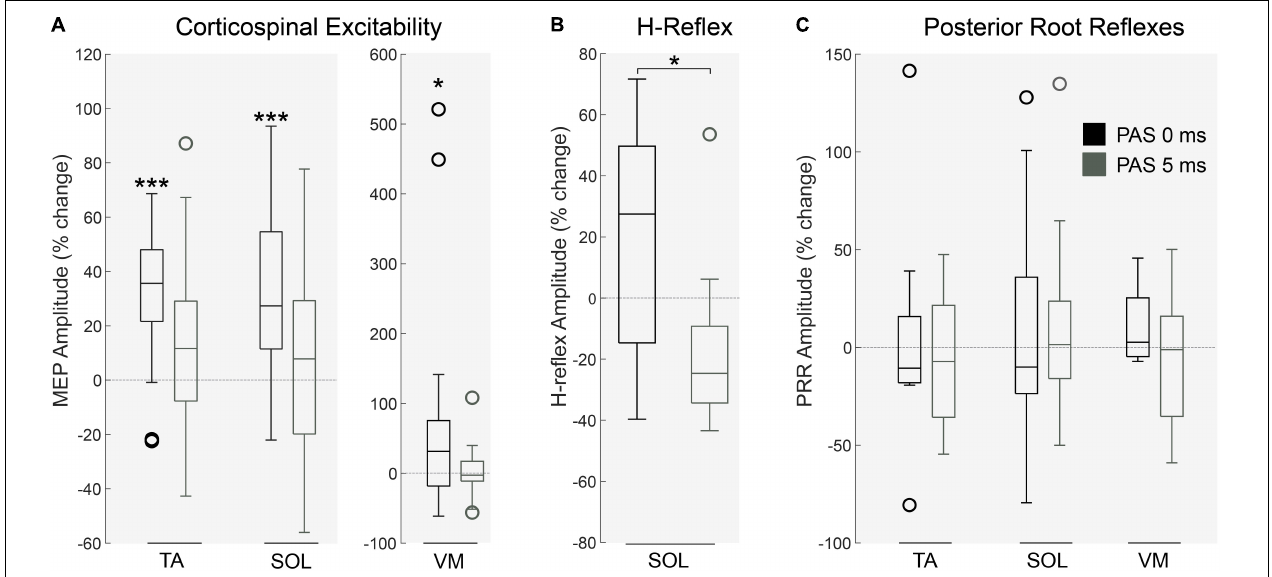
FIGURE 3 | Physiological changes following PAS protocol. (A) Corticospinal excitability in the right lower leg muscles was significantly altered by PAS interval ( p < 0.01, n = 22) in the TA ( p < 0.001), SOL ( p < 0.001) and VM ( p < 0.05) following PAS 0ms . This effect was similarly identified in the (B) amplitude of H-reflexes (in the SOL muscle), significantly increased by PAS 0ms ( n = 13, p < 0.05). Interestingly, (C) spinal root reflexes in the lower limb were unaffected by both PAS protocols ( n = 10, p > 0.05). Each box indicates the Upper (25 percentile) and Lower (75 th percentiles), the whiskers represent the minimum and maximum values, the central line is median value and open circles represent outliers (values that are more than 1.5 of the interquartile range away from the top or bottom of the box). * p < 0.05 *** p <